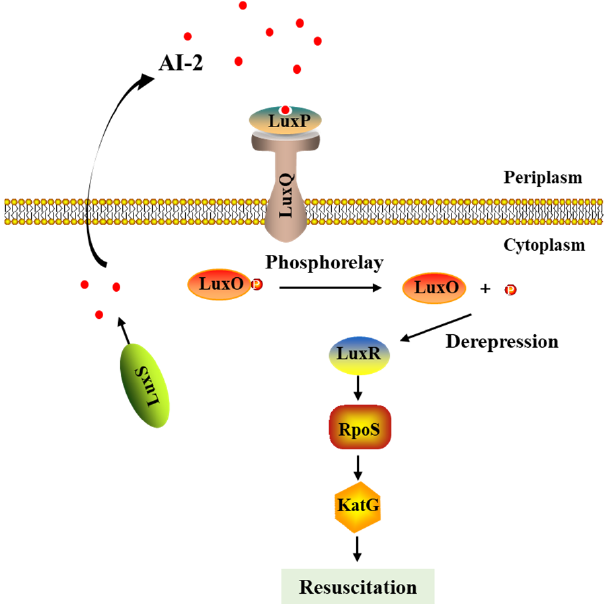
Figure 3. Generalized schematic of the effect of the QS phosphorelay system on the resuscitation of VBNC bacteria. The thin arrows mean promotion effects, and the thick arrow means transportation direction of AI-2.